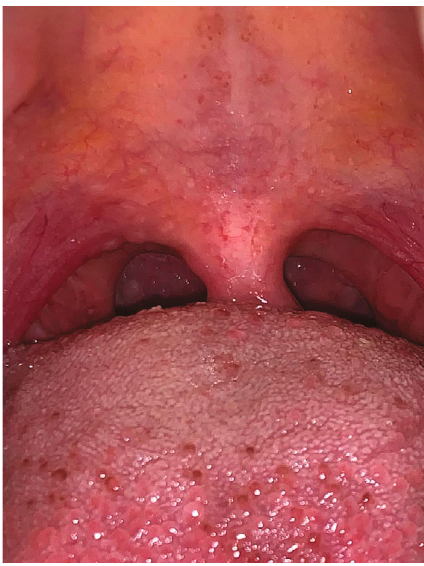
Figure 2: At eight-month follow-up visit, the yellow nodule in the left palatine tonsil completely